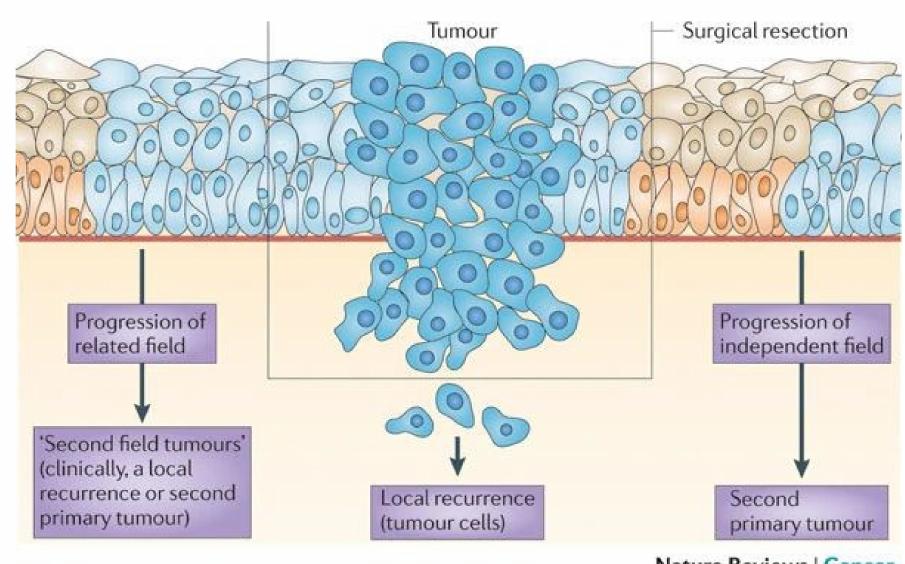
Figure 1. Taken from Leemans, C.R. et al. [11]. Schematic representation of the pathobiological origin of local relapse. A tumor has developed in the light blue preneoplastic field, is diagnosed and resected. Minimal residual disease is shown in the middle and may escape histological examination, leading to local recurrence. Additionally, the preneoplastic field can stay behind unnoticed when extending into the surgical margins. Progression of the remaining preneoplastic field could lead to a local relapse clinically diagnosed as local recurrence or second primary tumors, depending on the distance and time interval. At the right-hand side, the progression of an independent field is shown, which could also progress into a second primary